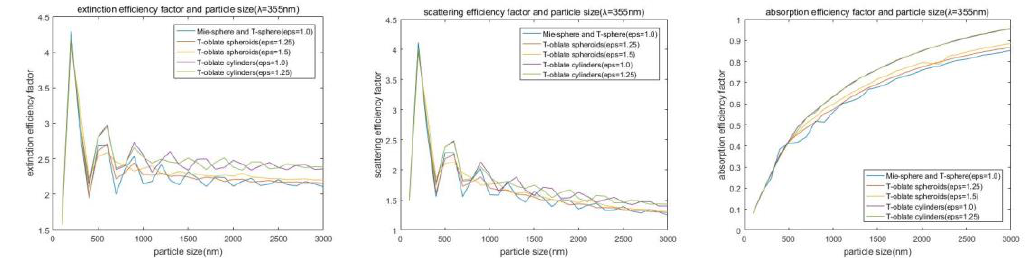
Figure 3. The extinction efficiency factor (left), scattering efficiency factor (middle) and absorption efficiency factor (right) of sphere, oblate sphere and oblate cylinder under the diameter 0 ~ 3um were compared by T-matrix method and Lorenz-Mie theory (The wavelength was 355nm and the refractive index was 1.55+0.01i)